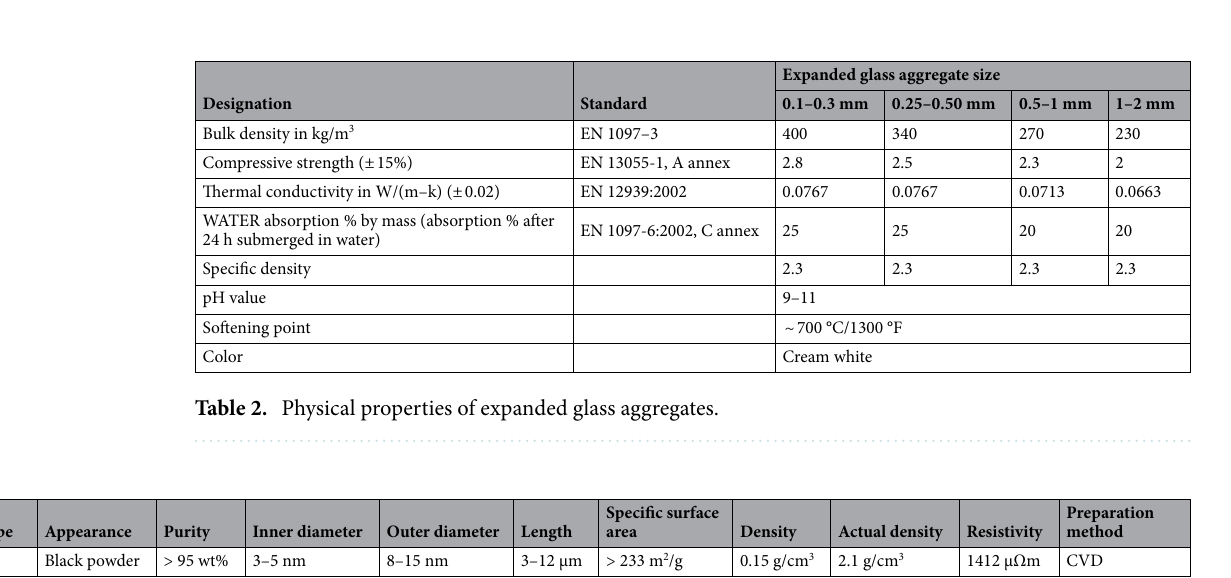
Table 1. Chemical properties of OPC and zeolite.